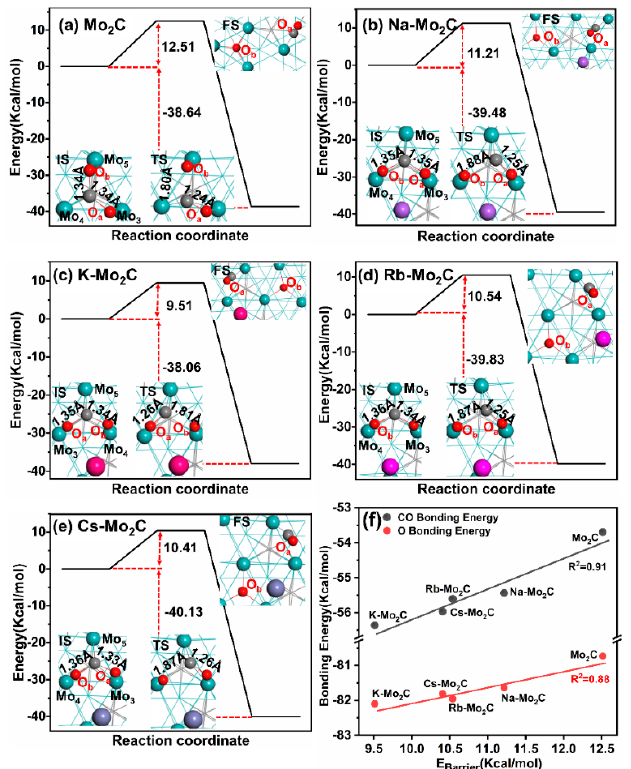
Figure 5. CO 2 dissociation profiles on ( a ) Mo 2 C, ( b ) Na − Mo 2 C, ( c ) K − Mo 2 C, ( d ) Rb − Mo 2 C, and ( e ) Cs − Mo 2 C. ( f ) Correlation between activation energy of the CO 2 dissociation and CO/O bonding energy.